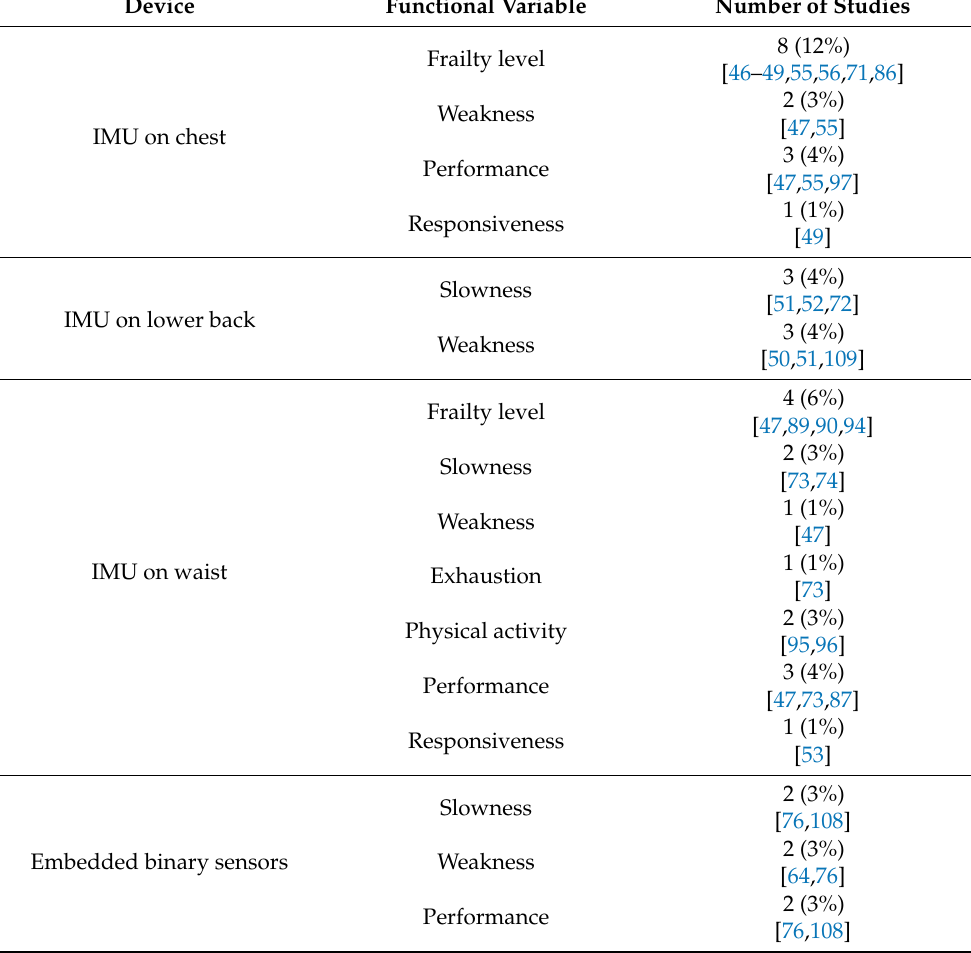
Table 11. Number of studies (right column) describing transparent assessment of any functional variable with each ubiquitous and on-body sensor. The figures in square brackets are the citations for the corresponding studies. The figures in brackets represent the percentage with respect to all 67 studies in the